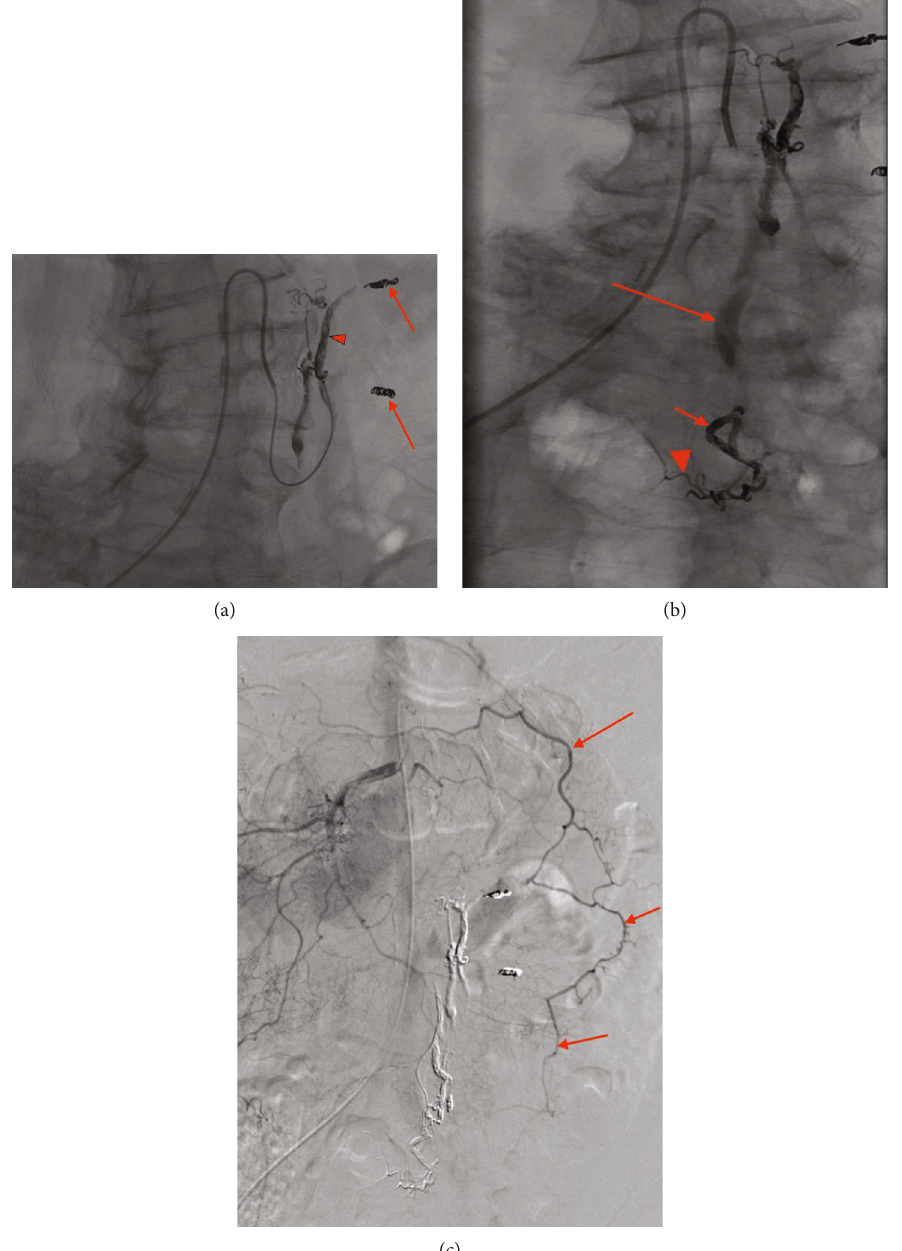
Figure 5: Intervention. (a) Coiling of left colic artery branches (arrows) prior to Onyx injection into the left colic artery (arrowhead) in order to prevent Onyx progression into the marginal artery. (b) Onyx embolization of the superior rectal artery (short arrow). Minimal fi lling of nontarget branches is also displayed (arrowhead). Onyx glue is seen through the AVM in the out fl ow vein of the left colic and superior rectal niduses. Inadvertent dissection of the IMA is demonstrated with stagnant contrast present in the IMA (long arrow). (c) Coils were deployed in two branches of the sigmoid artery to prevent Onyx fi lling of the marginal artery